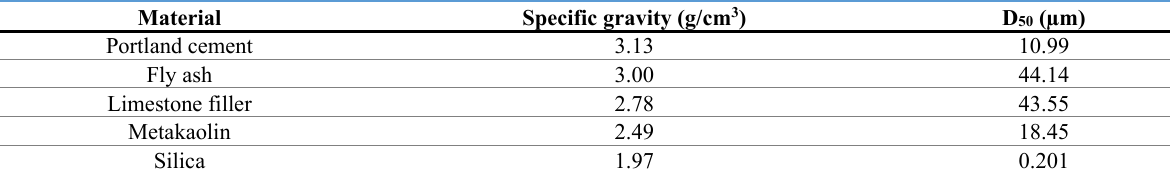
Table 2. Specific gravity and average diameter of fine powders